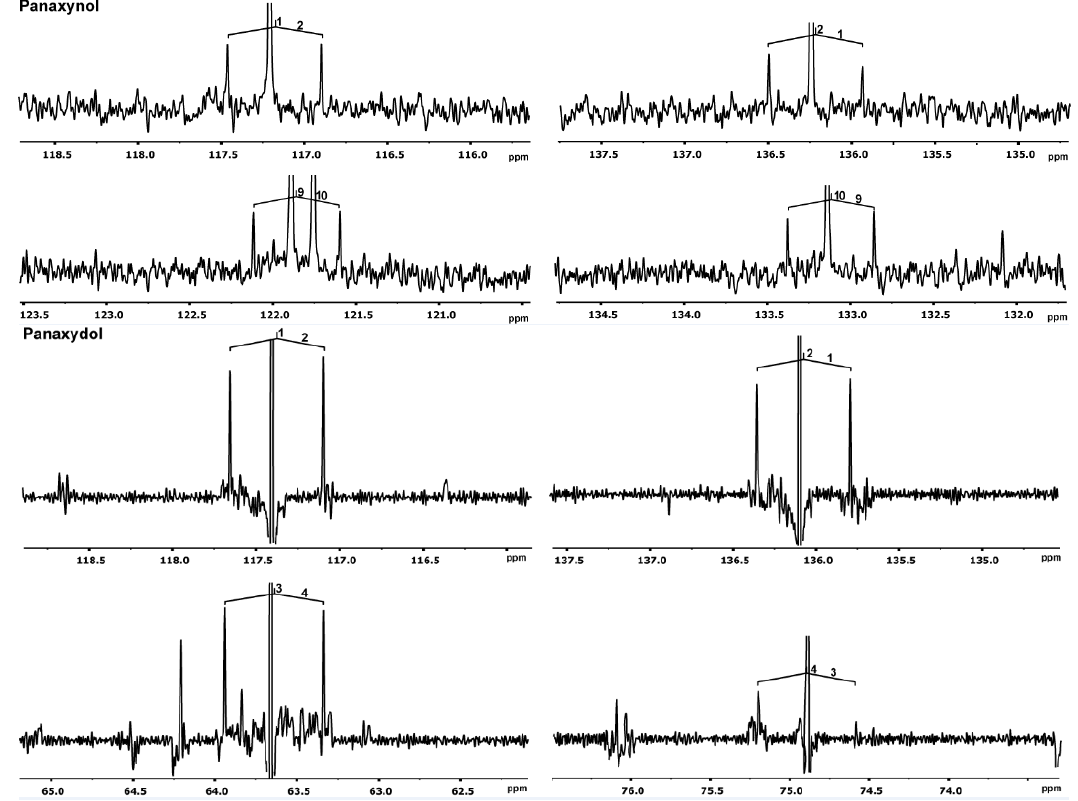
* nd, cannot be measured due to signal overlap. Figure 3. 13 C-NMR signals of panaxynol ( 1 ) and panaxydol ( 2 ) from the 13 CO experiment. Couplings between 13 C-atoms are indicated. Notably, satellites due to couplings between three adjacent 13 C-atoms are not observed in the upfield or downfield regions of the